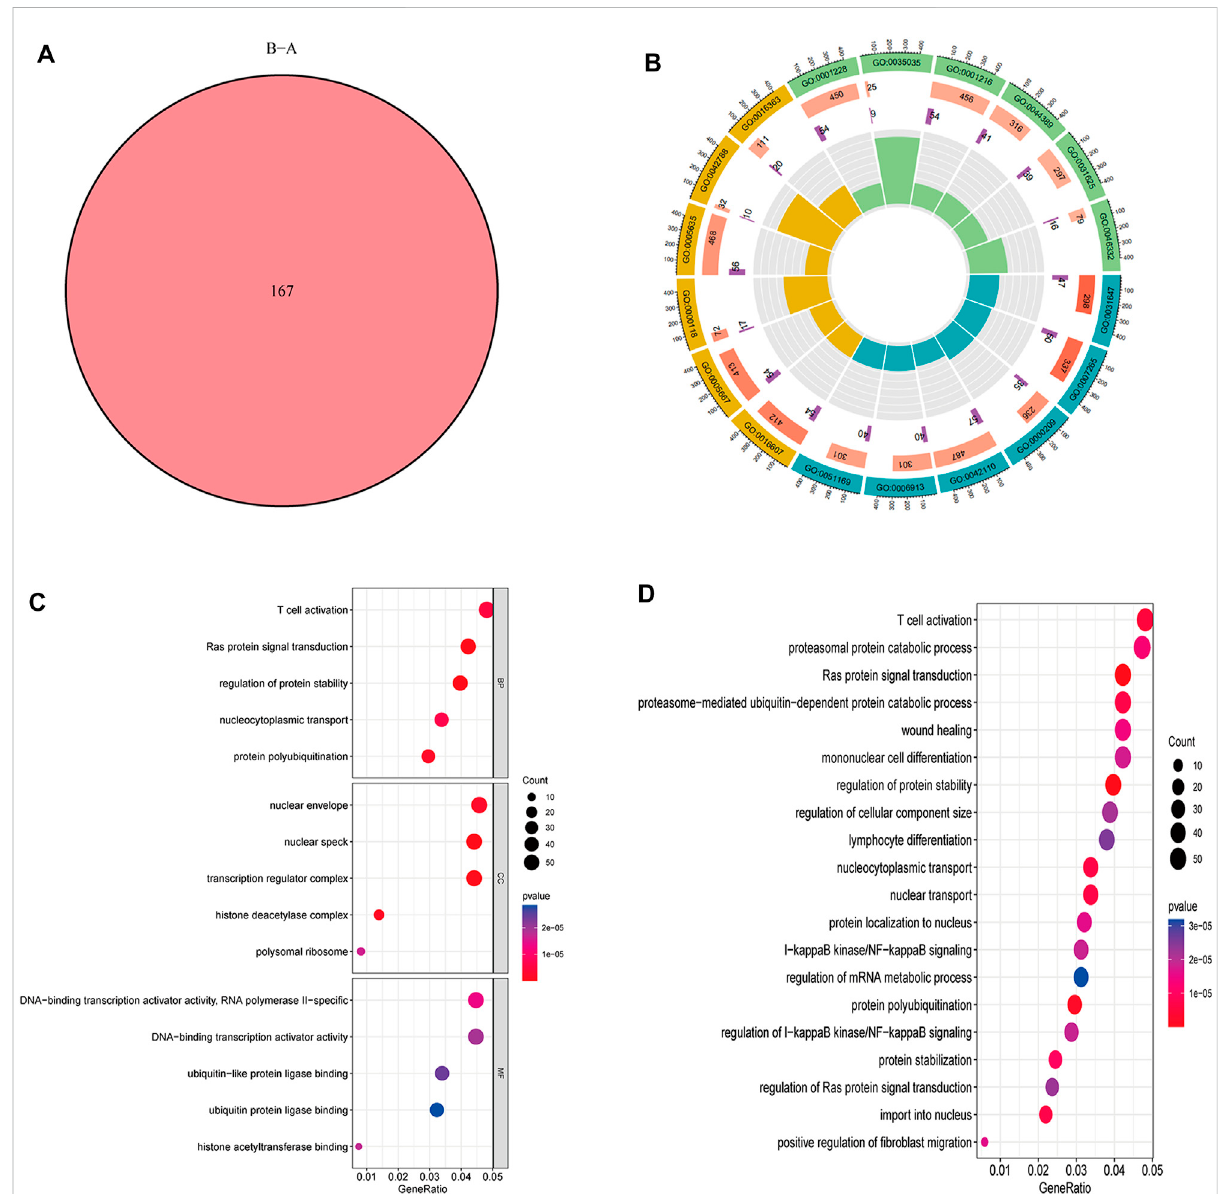
FIGURE 6 GO functional annotation and KEGG pathway analysis of DEGs based two m6A subgroups. (A) Venn diagram of DEGs. Circle (B) and bubble diagram (C) of GO functional annotation. (D) Top 20 KEGG pathway analysis of